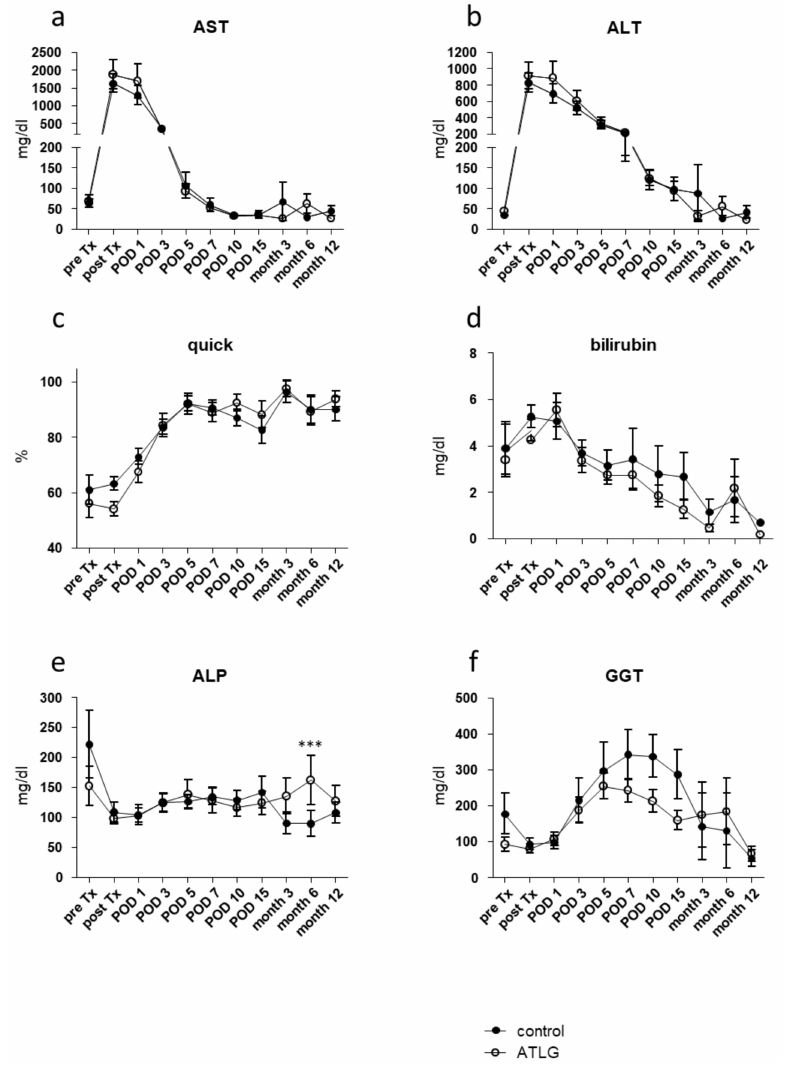
Figure 2. Functional liver parameter after liver transplantation. Results of routine blood analysis for the clinical parameters ( a ) alanine aminotransferase (ALT), ( b ) aspartate aminotransferase (AST), ( c ) Quick value, ( d ) bilirubin, ( e ) alkaline phosphatase, and ( f ) gamma-glutamyl transferase (GGT) are comparable for livers perioperatively perfused with ATLG as compared with control livers. ATLG: open circles; control: filled circles. data are presented as mean values ± SEM; *** p ≤ 0.001; ALP—alkaline phosphatase; ALT—alanine transaminase; AST—aspartate transaminase; ATLG—anti- human T-lymphocyte globulin; GGT—gamma-glutamyltransferase; POD—postoperative